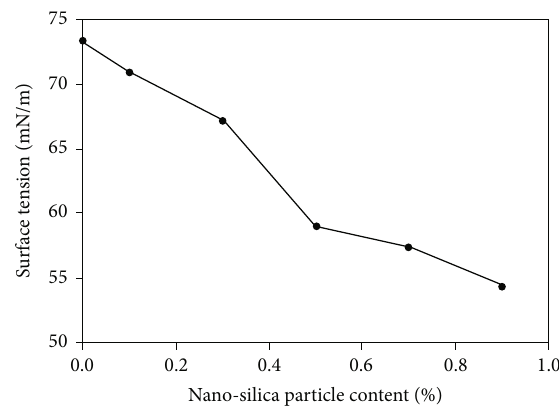
Figure 3: Relationship between nanosilica particle content and surface tension.